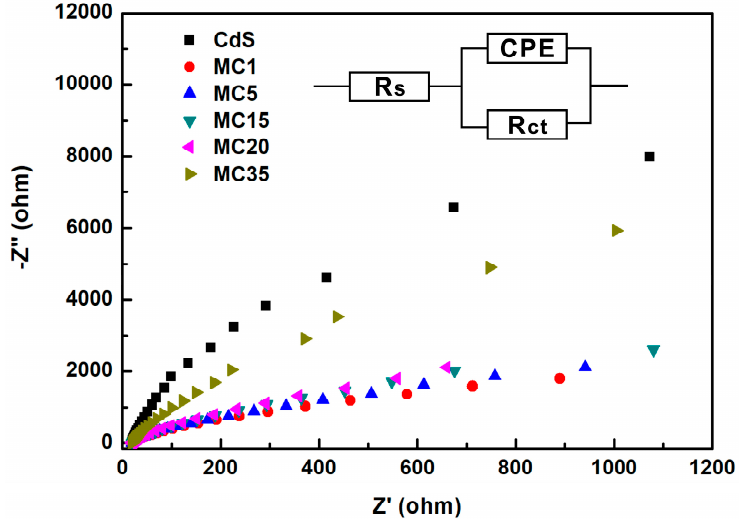
Figure 7. Electrochemical impedance spectroscopy (EIS) Nyquist plots of CdS and MoS 2 /CdS nanocomposites. CPE— equivalent element of double electric layer The Mott–Schottky plots can be used to investigate the semiconductor type and the flat band potential (E FB ) of the materials [10,29]. The positive slopes of the plots indicate that MoS 2 and CdS are both n-type semiconductors. Furthermore, the intercept of the x-axis indicates the E FB potential of the semiconductor. As displayed in Figure 8, the E FB positions of MoS 2 and CdS are estimated to be − 0.11 V and − 0.60 V (vs. RHE), respectively. The gap between E FB and the bottom of the conduction band